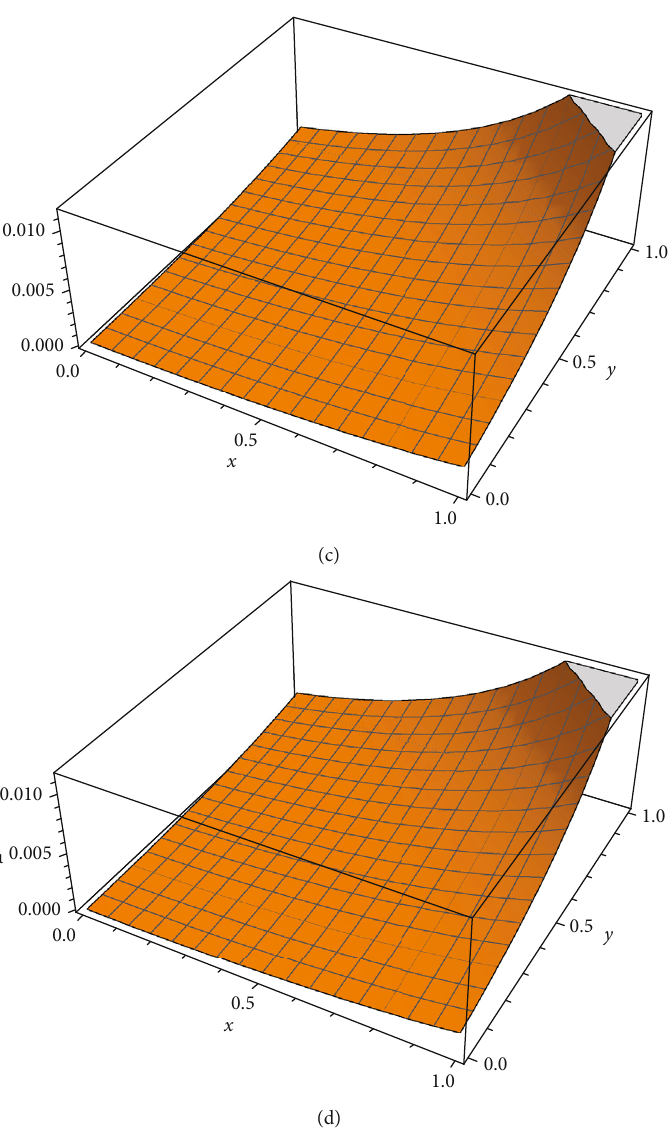
for μ = 0 : 60 , (b) NTDM CF